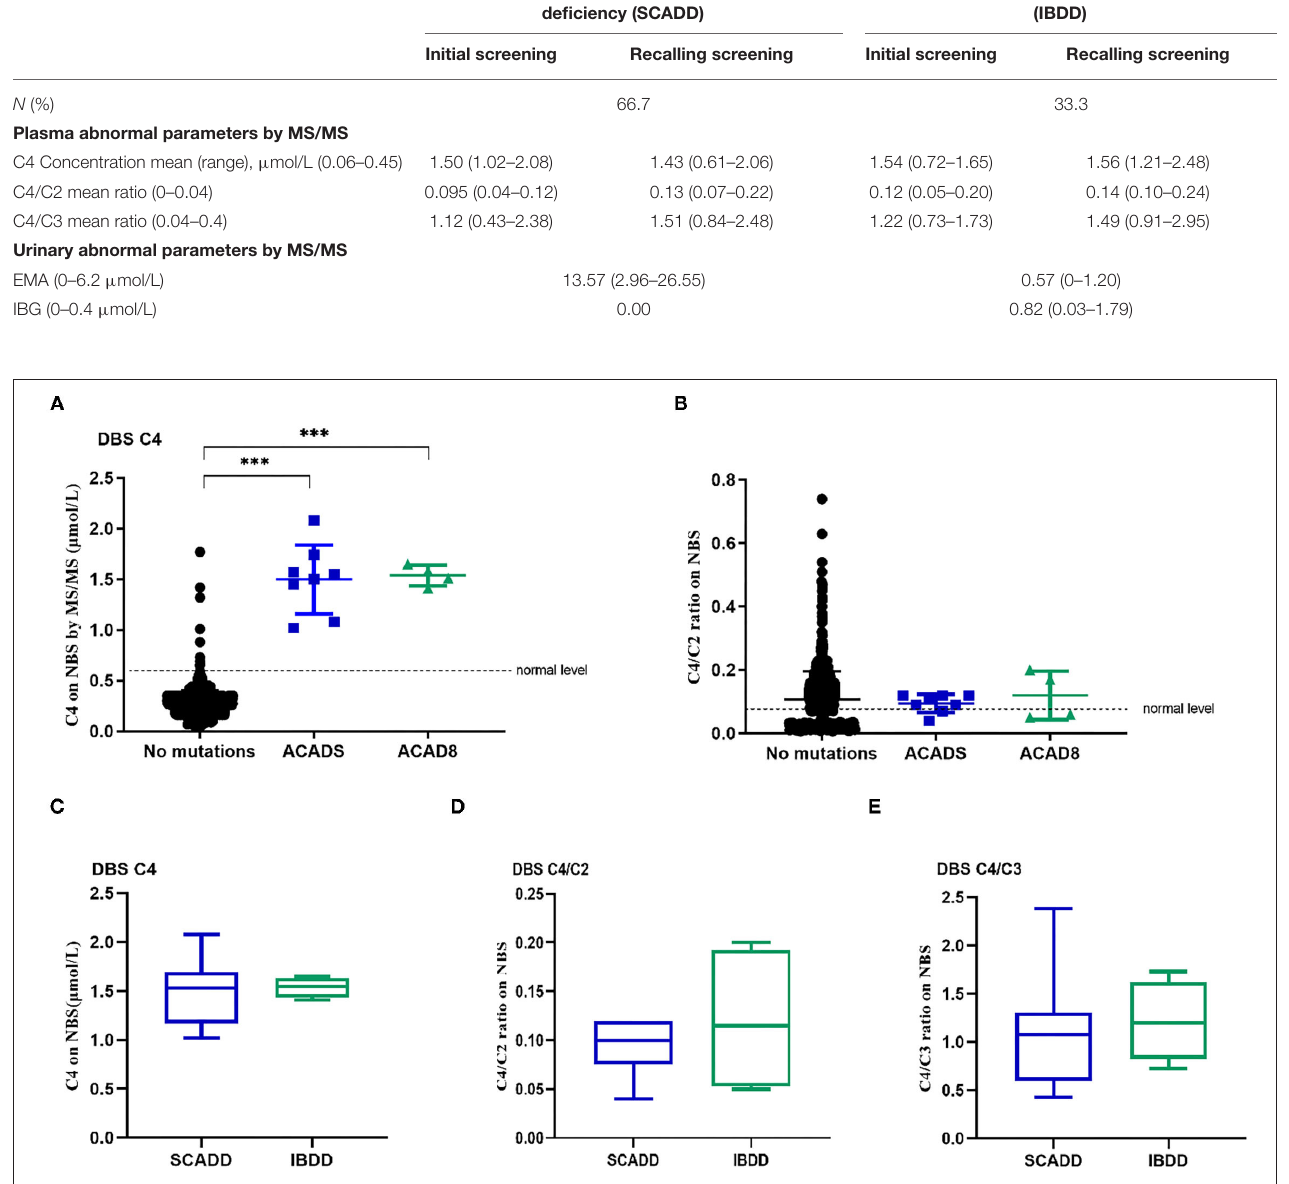
FIGURE 1 | Metabolite levels in individuals with molecularly confirmed ACADS and ACAD8 variants. (A) Levels of C4 identified by newborn screening. (B) C4/C2 ratios obtained from newborn screening. (C–E) Box plots of biochemical tests using MS/MS for SCADD compared to IBDD. (C) C4-acylcarnitine concentrations identified by newborn-screening blood spots (DBSs C4). (D) C4/C2 ratios in DBSs. (E) C4/C3 ratios in DBSs. (* p < 0.05; ** p < 0.01; *** p <